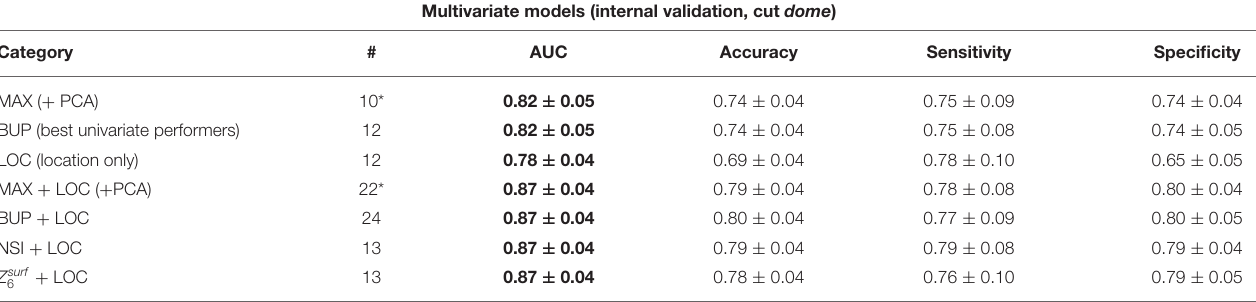
TABLE 6 | Internal validation results of the multivariate classification models.